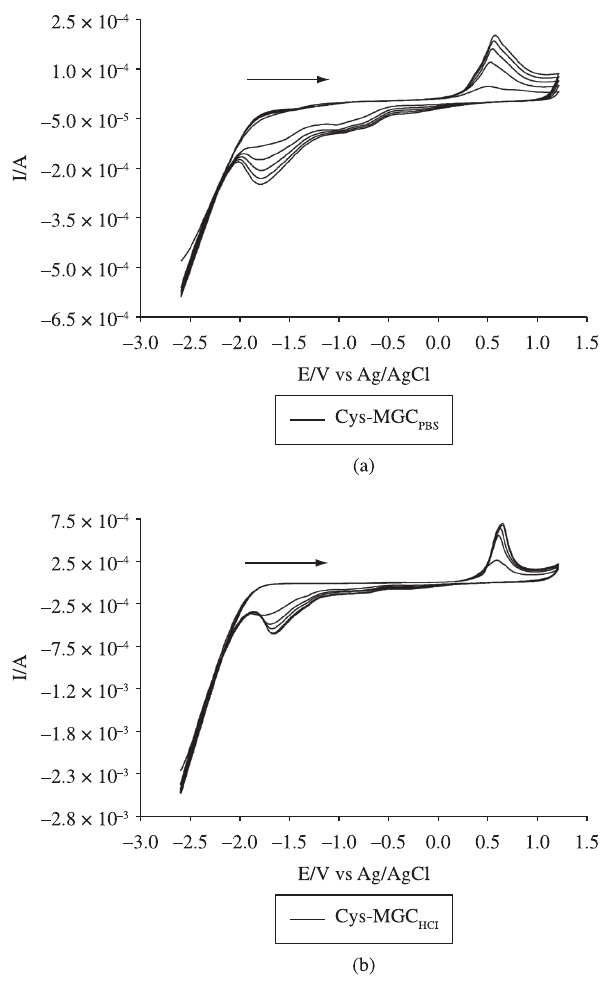
Figure 1. Cyclic voltammograms of the glassy carbon electrodes modified by cysteine in a) 0.04 M HCl and b) PBS containing 5.0 × 10 –3 mol.L –1 of L-cysteine; scan potential from –1.2 to 2.6 V and scan rate 100 m.V/s.